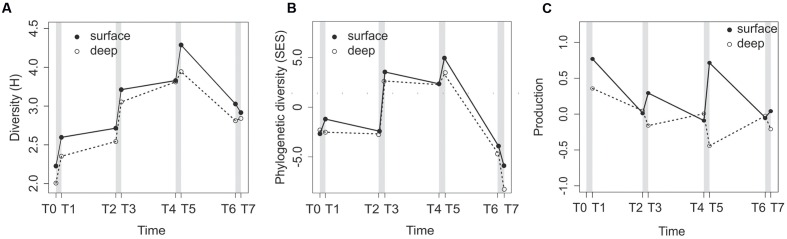
Changes in the RNA-based community diversity
(A) and phylogenetic diversity (B), and prokaryote production expressed as the change in the number of cells per mL of sediment and per day (C) in the surface and deep sediment layers along the course of the experiment. Gray bars represent the disturbance events.